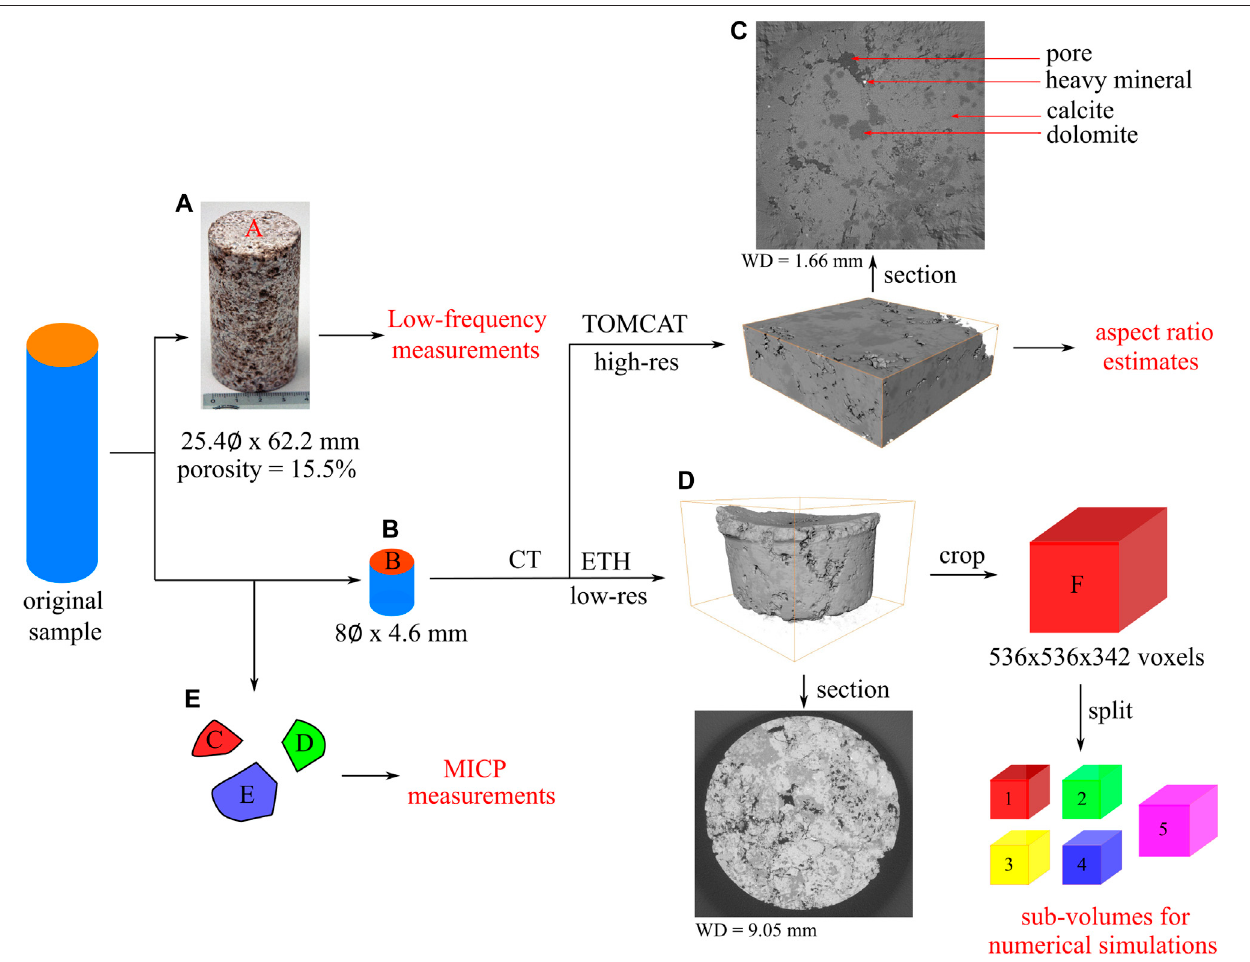
FIGURE1| Sampledescriptionsandwork fl owoftheprocess.Theoriginalsamplewascutintosample (A) forthelow-frequencymeasurement.Theremainingpart ofthesamplewasusedforCT-scan(sample B )andMICPmeasurement(sample C – E ).Sample (B) wasscannedattwofacilities:TOMCATandETH.TheTOMCATscan providedhigh-resolutionimagesinwhichweuseforestimatingaspectratioofporespaces.TheETHscan,whoseresolutionwaslower,coveredmoreareaofthesample and was used for numerical simulations. The ruler in the sample (A) fi gure is in centimeters and WD represents the width of the image.